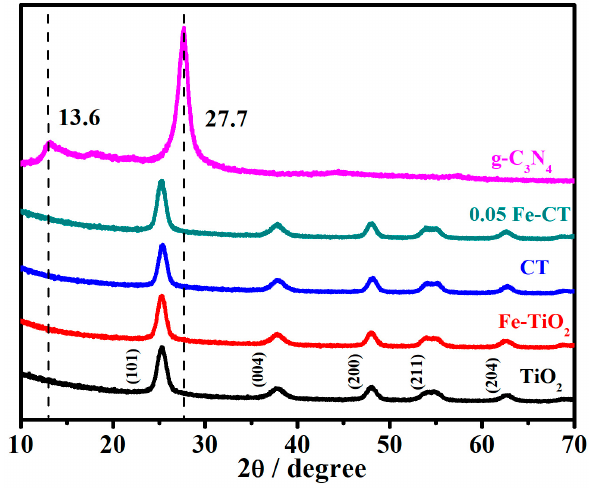
Figure 1. XRD patterns of TiO 2 , Fe ‐ TiO 2 , CT, 0.05Fe ‐ CT, and g ‐ C 3 N 4 .